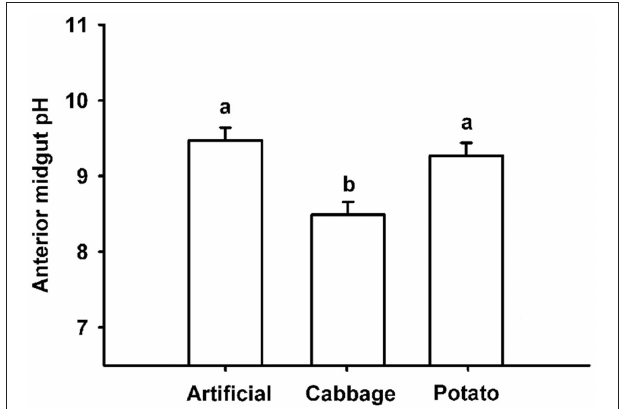
FIGURE 2 | pH values in anterior midguts of 4th instar T. ni raised on artificial diet, cabbage, and potato. Different letters represent significant differences p < 0.001 using a one-way ANOVA coupled with a post-hoc multiple comparison Holm–Sidak test.